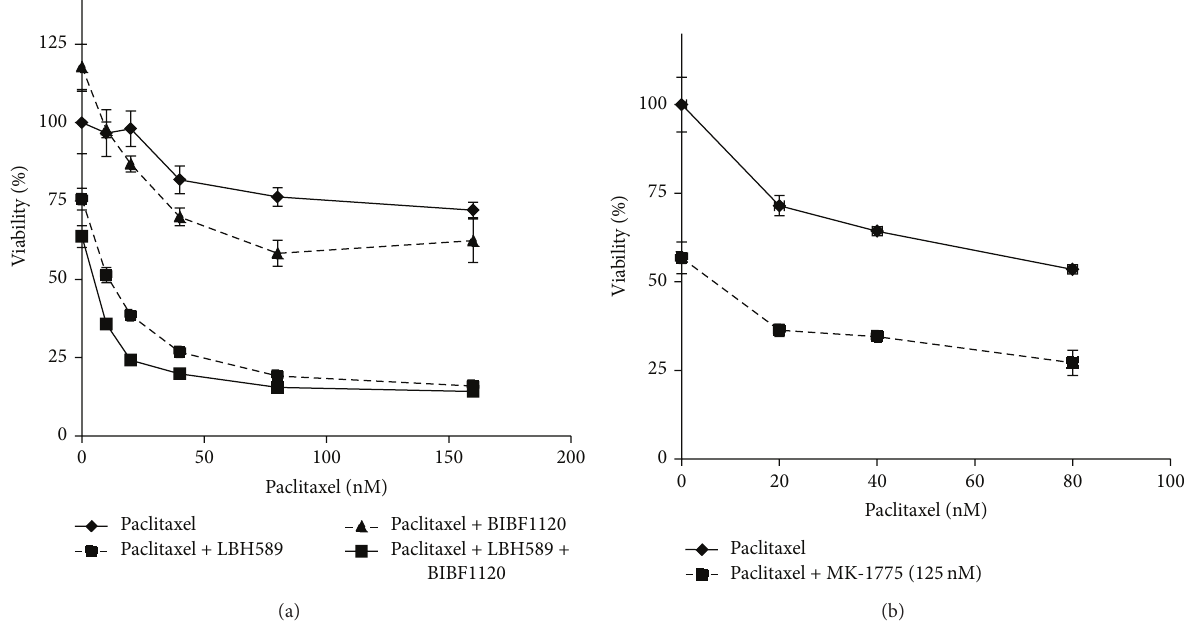
Figure 6: Strategies to achieve synthetic lethality in cells with p53 GOF mutation. (a) KLE endometrial cancer cells, which contain R175H p53 GOF mutation, were treated with increasing concentrations of paclitaxel in the presence of 10nM LBH589 − /+ BIBF1120 (1 𝜇 M) for 72 h, followed by assessment of cell viability by Wst-1 assay. (b) KLE cells were treated with increasing concentrations of paclitaxel − /+ Wee1 inhibitor MK-1775 (125nM) for 72 h, followed by assessment of cell viability.